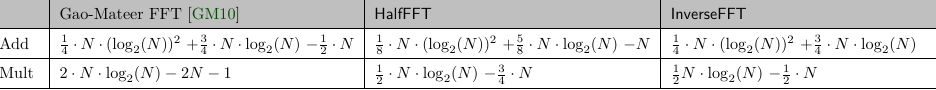
Table 1: Complexity of our variant of Gao-Mateer additive FFT.